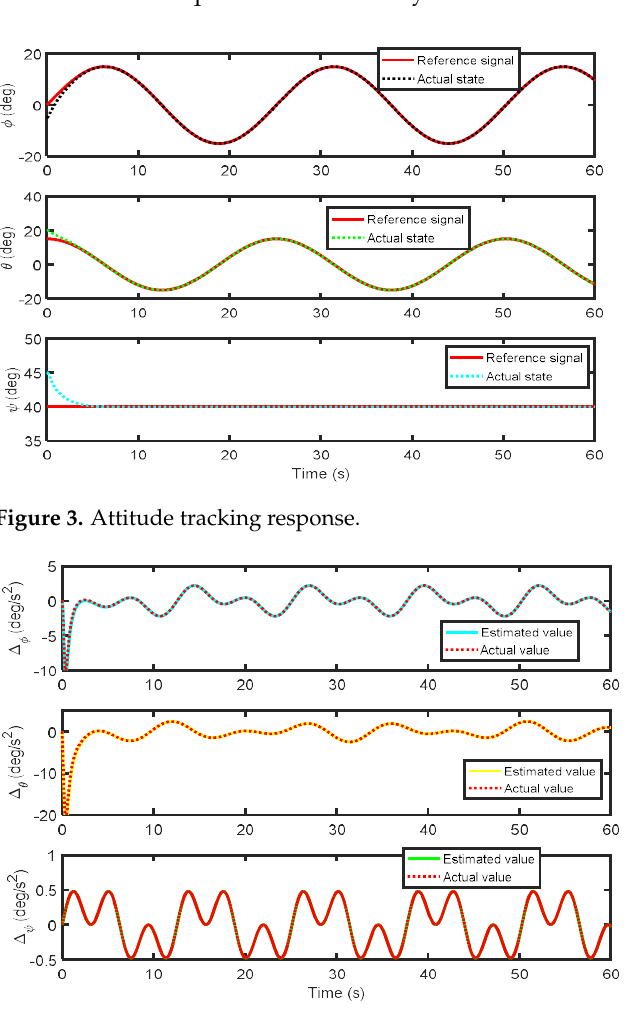
Table 2. Parameters of the controllers.